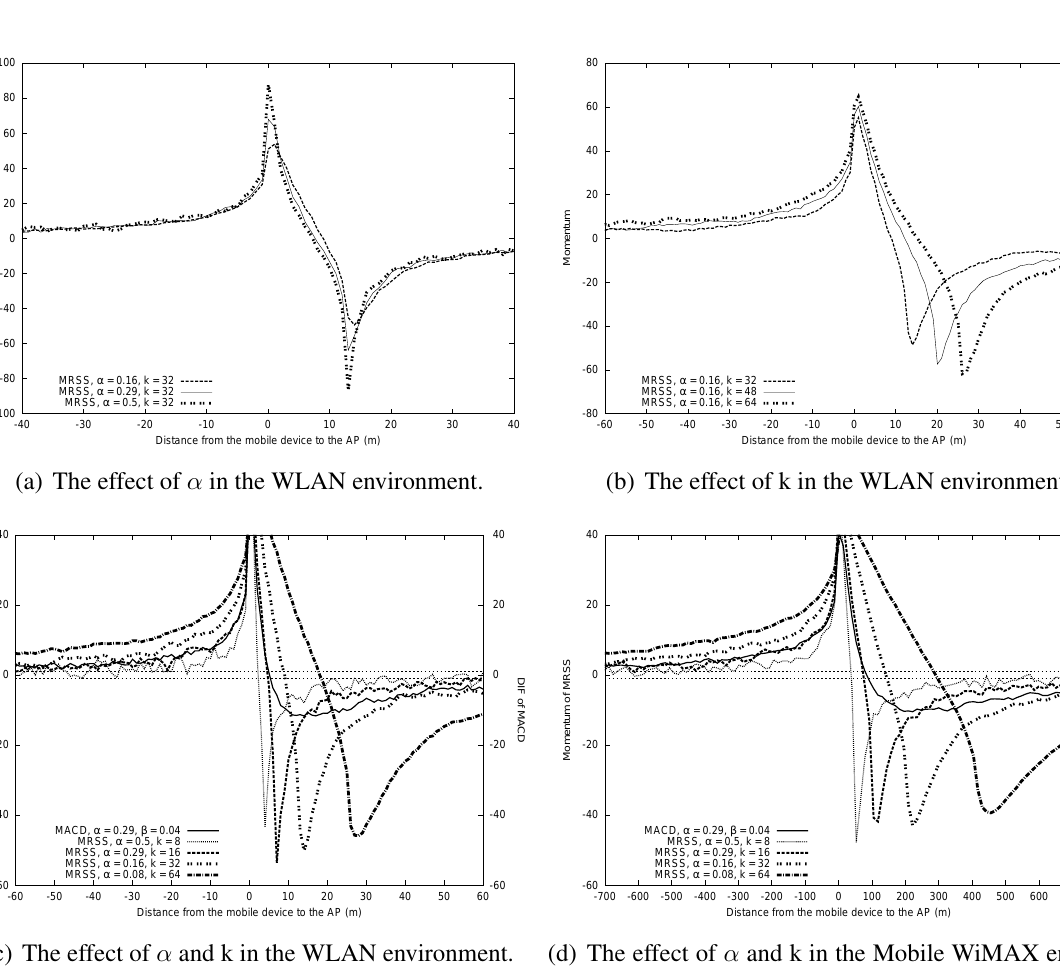
Figure 5. The performance evalution of α and k